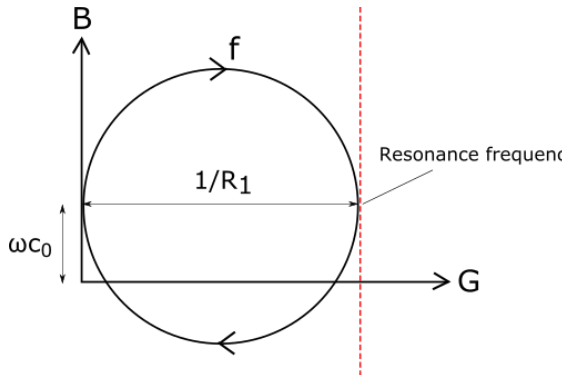
Figure 10. Admittance plot of